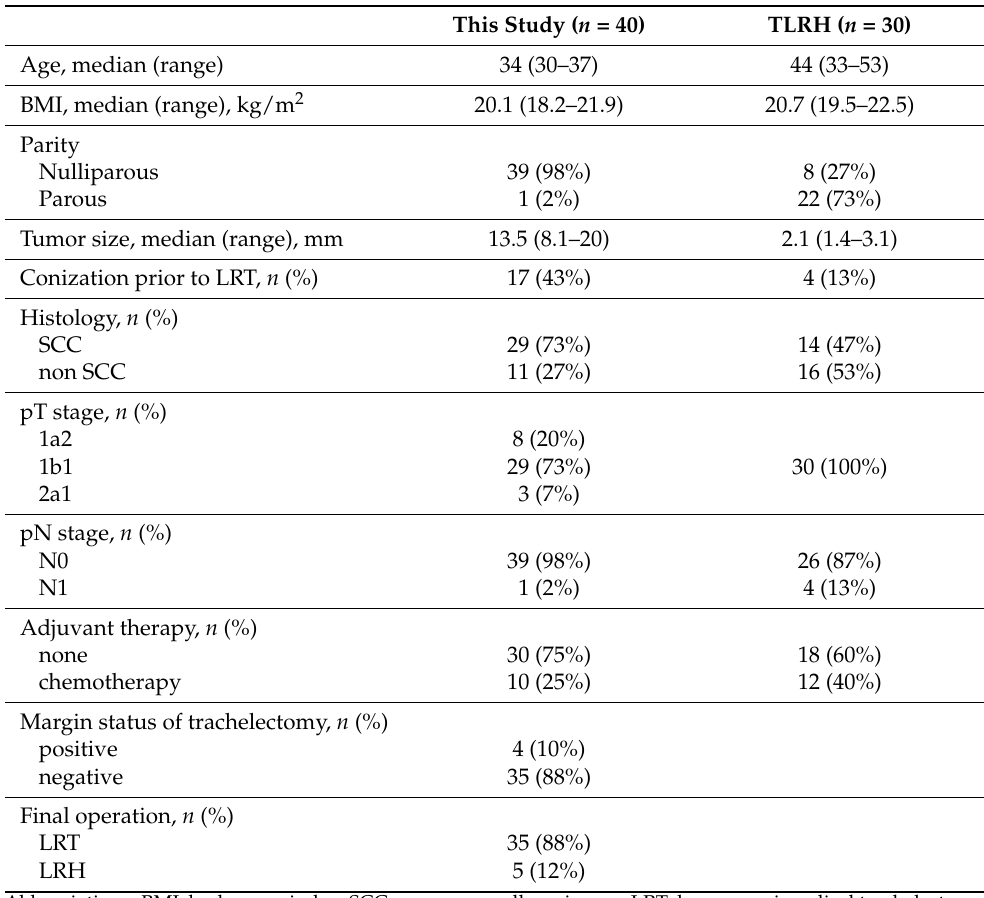
Table 1. Clinical characteristics of